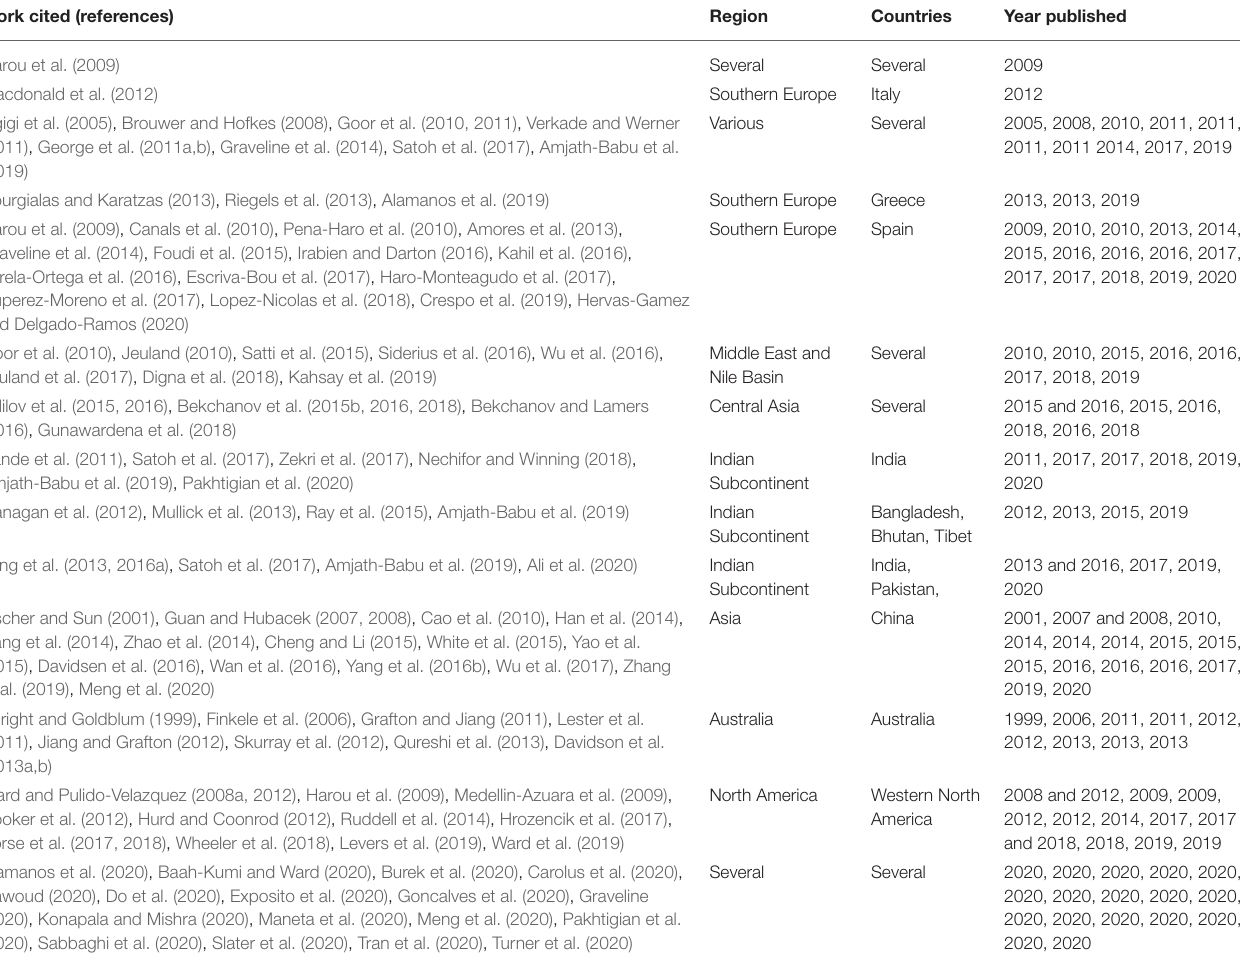
TABLE 7 | Selected notable works since 2009 supported by hydroeconomic